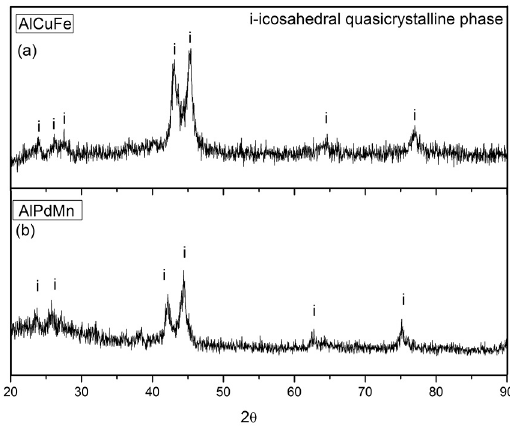
Cu Fe and Al Pd Mn 65 20 15 70.5 21 8.5